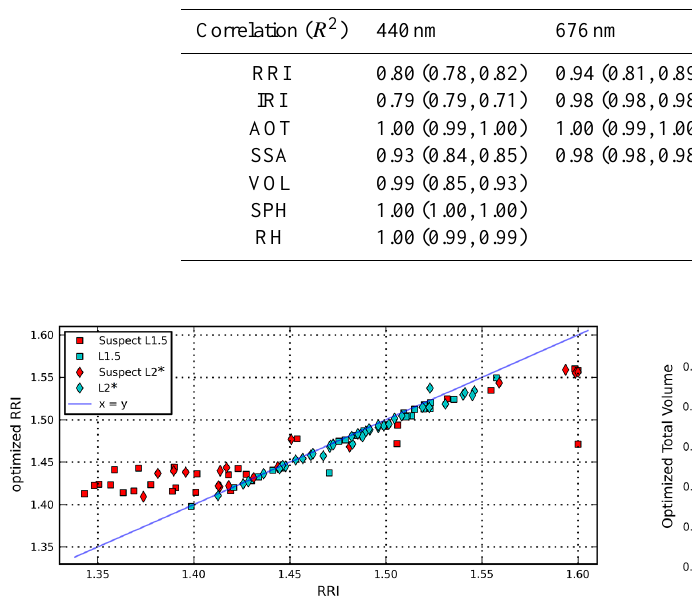
Figure 3. Scatterplot of model computed (optimized) and AERONET level 1.5 (squares) and L2 ∗ (diamonds) real refractive index (RRI) data averaged over four wavelengths. Model results have been marked “suspect” (red) when the AERONET refractive index is outside the range that our model can simulate and/or when the cost function is larger than 10. The blue line shows the 1 : 1 ratio.